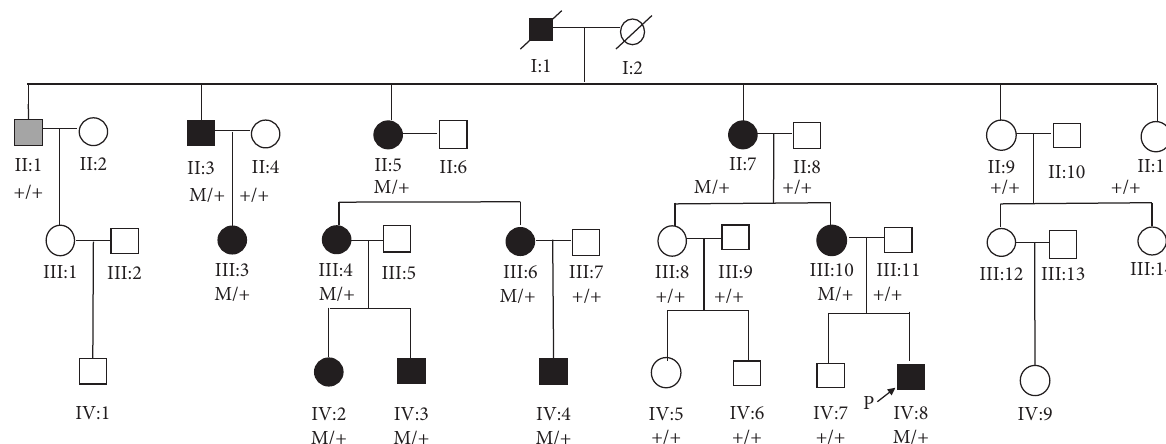
Figure 1: Pedigrees of the Chinese family with congenital posterior polar cataract via autosomal dominant inheritance. Square: male; round: female; black symbols: patient; white symbols: healthy individual; slash: passed away; arrow: the proband; M: variant; +: wild